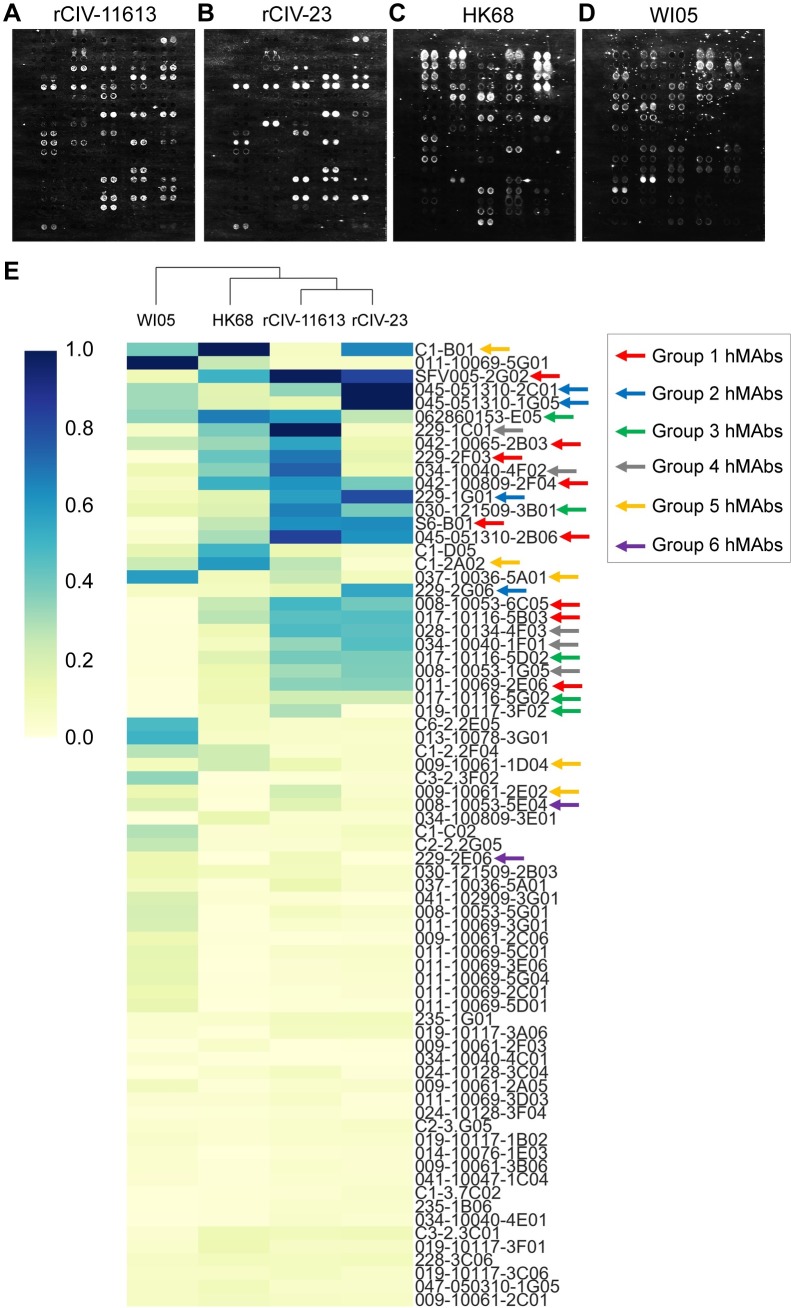
Cross-reactivity of hmAbs by AIR.AIR images of arrays exposed to (A) rCIV-11613 H3N2, (B) rCIV-23 H3N8, (C) HK68 and (D) WI05 viruses. (E) Hierarchical cluster map of the hmAb responses. Values in this map are scaled relative to the antibody producing the strongest response for each virus. Arrows show the antibody clustering groups.